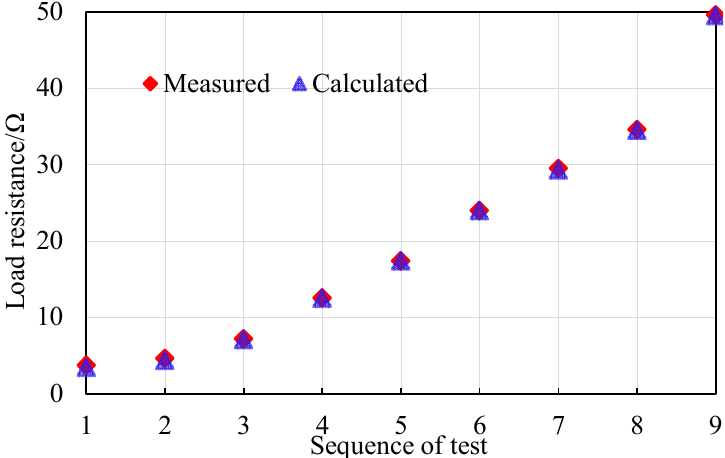
maximum error was 7.4% and the minimum error was 0.5%.